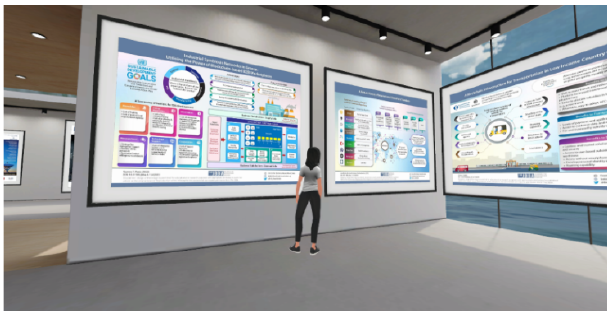
Figure 17: JBBA Blockchain Research Infographics gallery in the metaverse